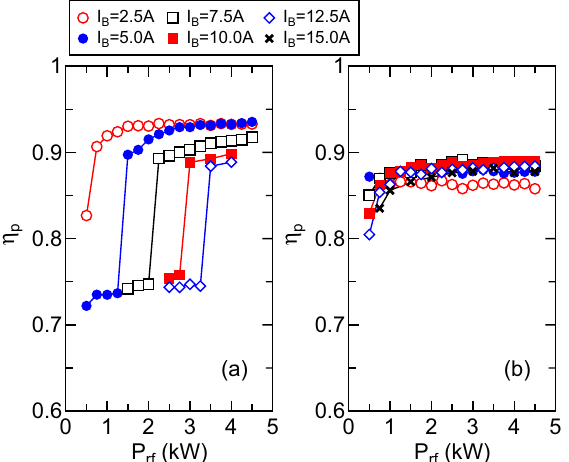
Figure 3. Measured rf power transfer efficiency η p for various values of the solenoid current I B as a function of 0 mode loop antenna. Typical error 1 mode helical antenna and ( b ) the m the rf power P rf for ( a ) the m = = + 5% . The discontinuous change in η bar is about p , which would be a discharge mode transition, is observed ± 0.9 is obtained for the efficient coupling conditions, while the 1 case and the efficiency of η for the m p > = + 0 case is less than 0.9 with no mode efficiency for the m =